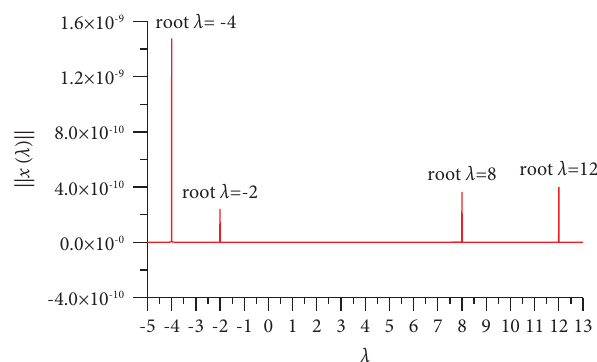
Figure 6: For Example 2, showing four picks of ‖ x ‖ , corresponding to eigenvalues − 2, − 4, 12, and 8.